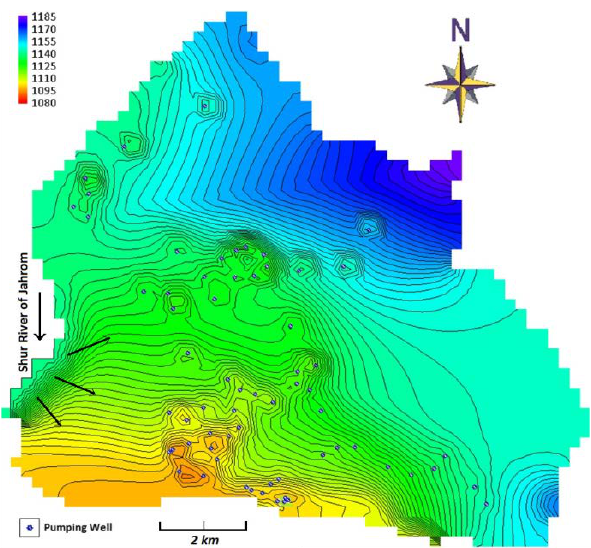
Fig. 5. Average groundwater contour map (meter above mean sea level) of the GBP during 12 months between April 2005 and March 2006, with active pumping wells but with no surface recharge.